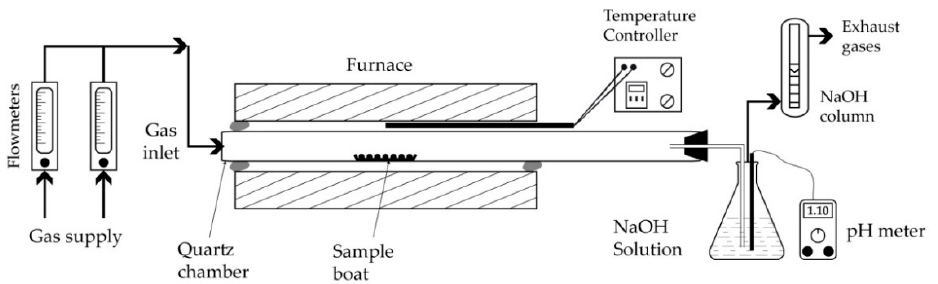
Figure 2. Schematic presentation of the experimental setup.